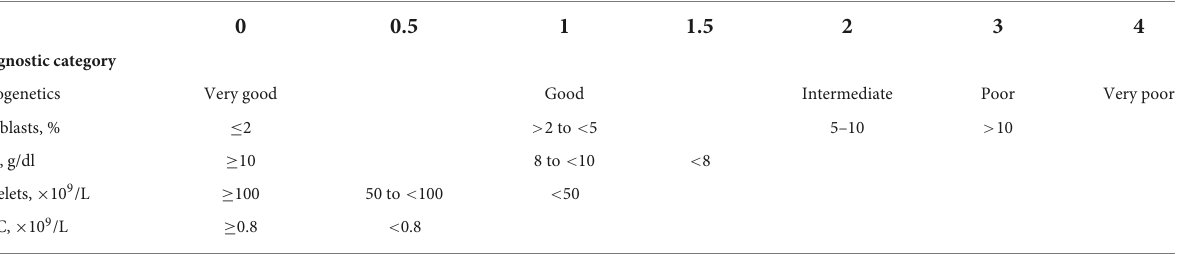
TABLE 1 R-IPSS scoring system (13).